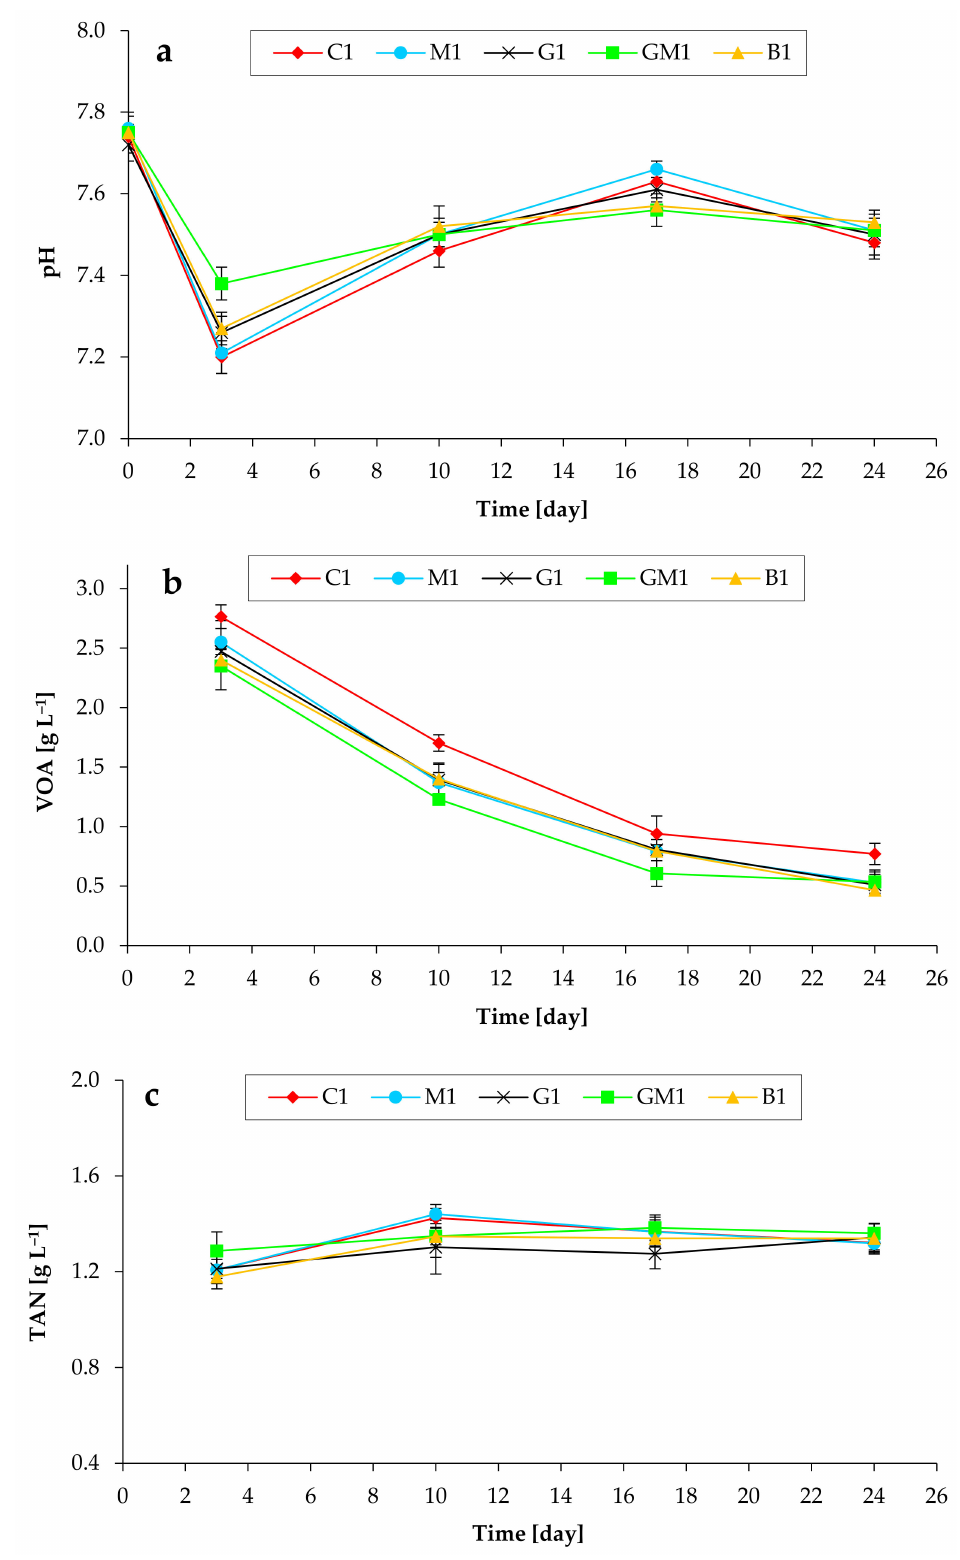
Figure 2. Impact of various additives addition on pH changes ( a ), volatile organic acids (VOA) concentrations ( b ), and total ammonia nitrogen (TAN) concentrations ( c ) during anaerobic digestion of chicken manure (TS of